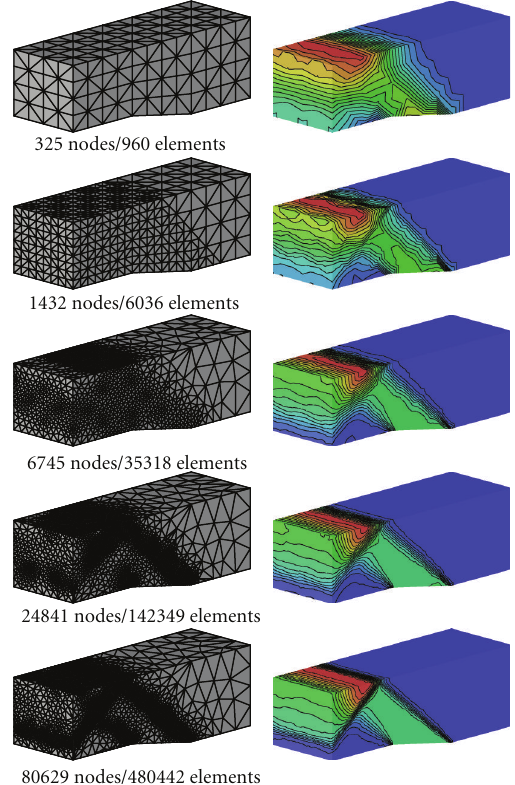
Figure 16: Evolution of the 3-dimensional wedge and the corre- sponding solution field (density) for M ∞ = 2 . 0.